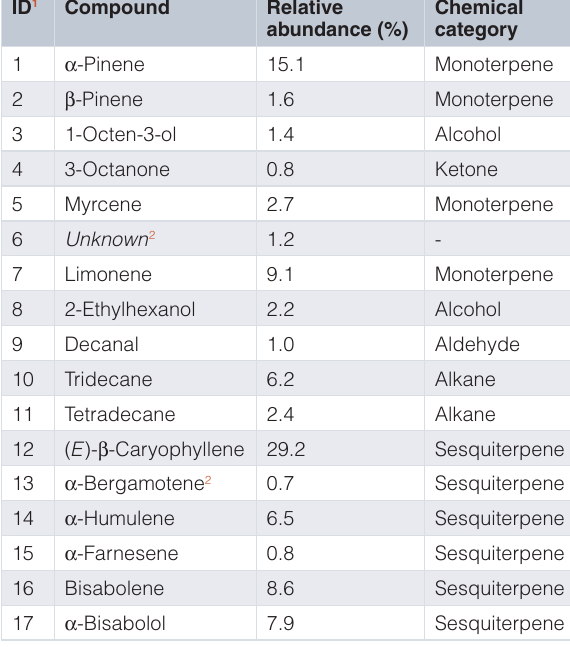
Table 1. Composition of headspace volatile organic compounds emitted by cotton-fed Heliothis virescens larvae. This